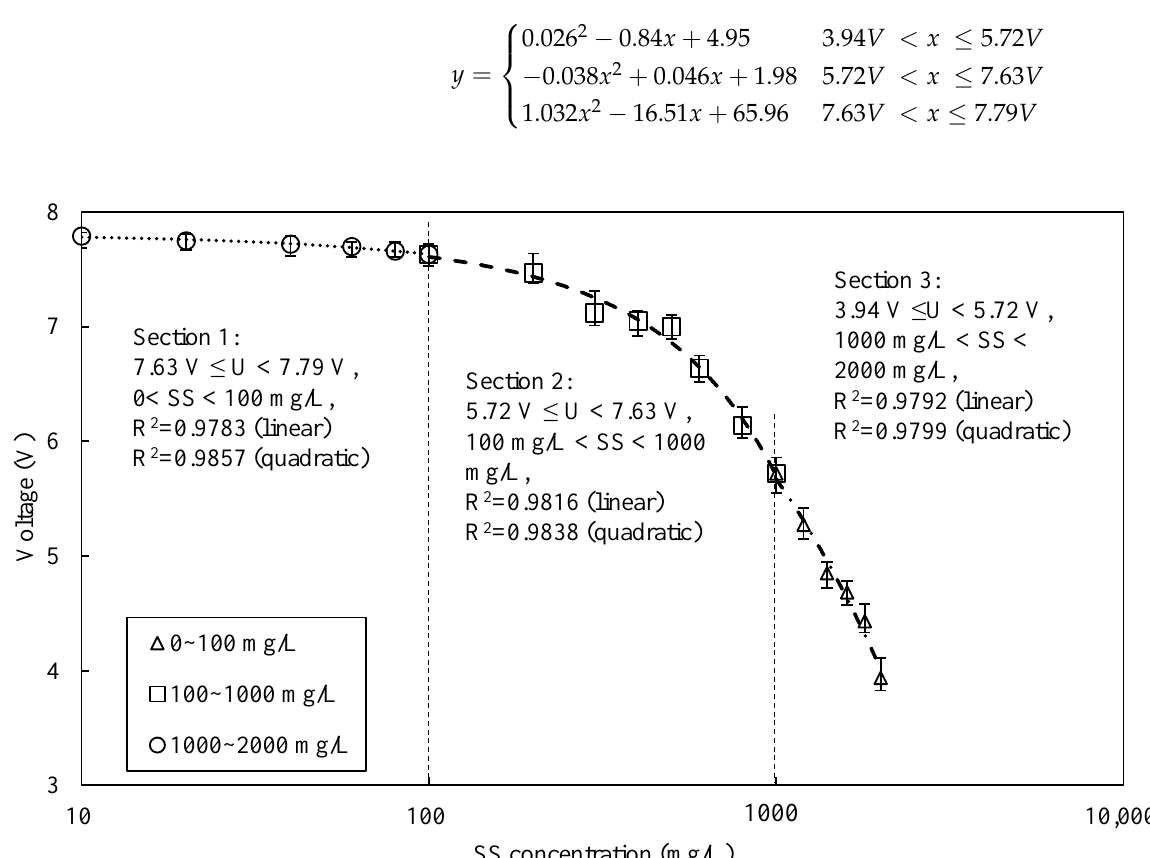
Figure 2. Calibration curve drawn with quadratic fitting between voltage and suspended solid concentration. Error bars represents range of observed values.